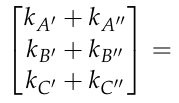
+ k k A A (cid:48)(cid:48) (cid:48) + k k = k B B (cid:48)(cid:48)  (cid:48) + k k C C (cid:48)(cid:48) (cid:48) 